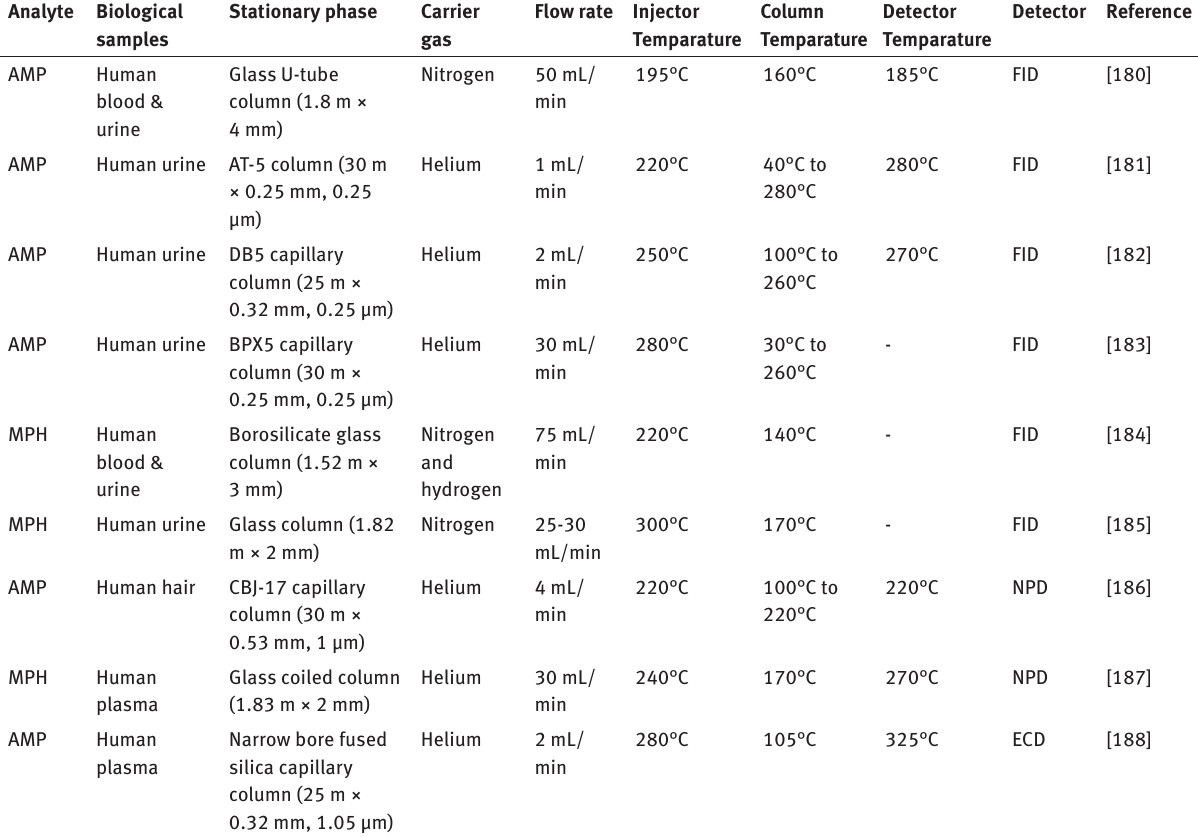
Table 3: GC methods for the determination of AMP and MPH in human biological samples. Analyte